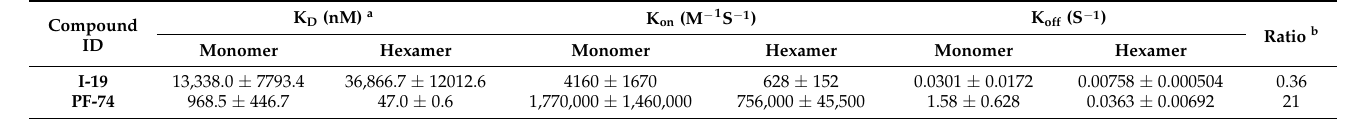
Table 2. SPR results of I-19 and PF-74 binding to CA monomer and hexamer.